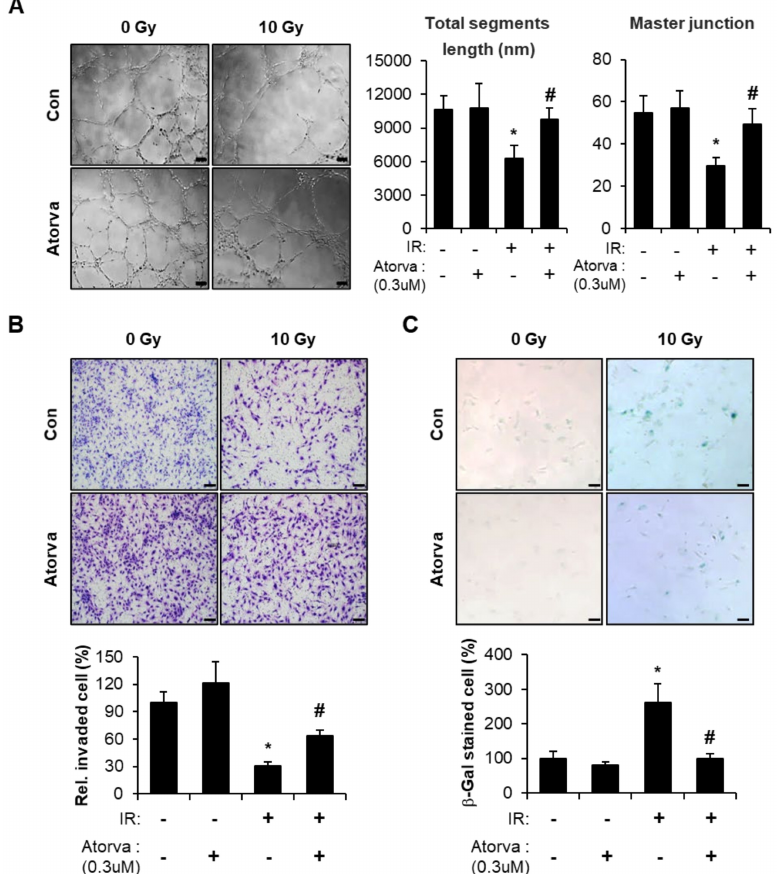
Figure 1. Atorvastatin mitigates radiation-induced endothelial cell dysfunction. ( A ) Tube formation in atorvastatin-treated irradiated human umbilical vein endothelial cells (HUVECs). Representative images of HUVECs seeded on Matrigel in the presence (Atorva) or absence of atorvastatin (left). Total segment length (middle) and number of master junctions (right) were quantified and plotted. ( B ) Invasion in atorvastatin-treated irradiated HUVECs. Representative images of migrated HUVECs on trans-wells (upper). Cells that invaded were quantified and plotted (lower). The invaded cells in nine randomly selected fields were counted under a light microscope. Bars represent the percentage of invaded cells normalized to that of the corresponding control. ( C ) Senescence-associated (SA) β -galactosidase activity in atorvastatin-treated irradiated HUVECs. Representative images were obtained by light microscopy. Senescent cells were quantified and plotted (lower). Data are presented as the mean of ± standard deviation of triplicate experiments. Images are representative of 3 independent experiments. * p < 0.05 vs. negative control (Con), # p < 0.05 vs. irradiated control (IR). Scale bars represent 100 µ